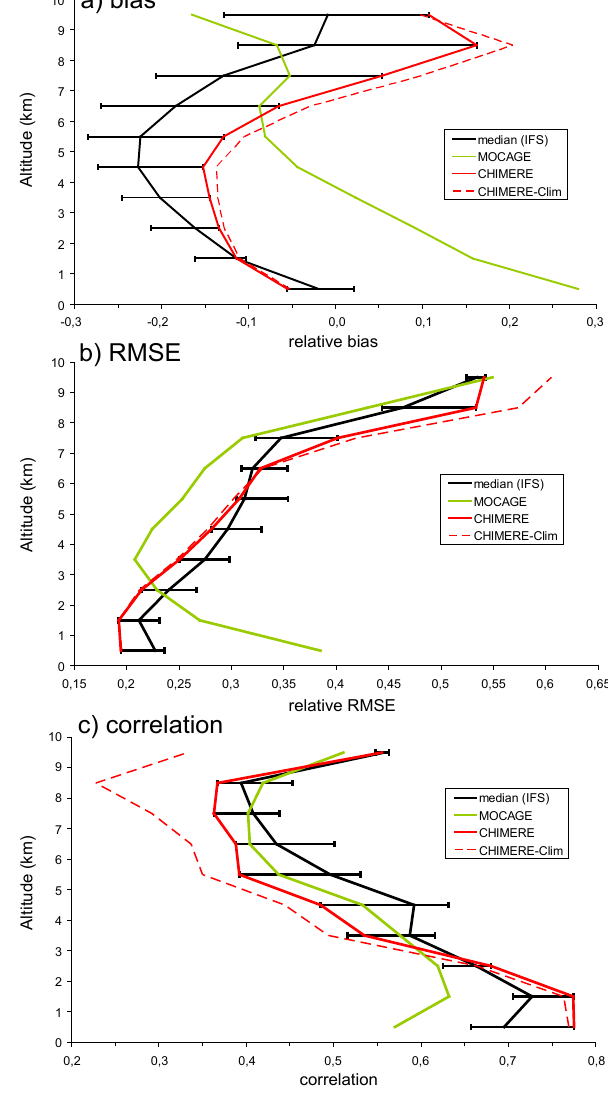
Fig. 3. Vertical profiles (y-axis inkm) of normalized (with respect to measurements) (a) relative bias (Model minus Observations), (b) relative RMSE and (c) Pearseon’s correlation coefficients. Values are averaged over 1km vertical layers using all 395 available pro- files of ozone. Black curves indicate the medians of the five models using IFS-MOZART at their boundaries (i.e. BOLCHEM, CAMX, CHIMERE, EURAD) and IFS-MOZART itself. Each value is also associated with the minimum and maximum value of the ensem- ble (bars). Results for MOCAGE (green), CHIMERE-IFS (full red) and CHIMERE Clim (dashed red) (i.e. CHIMERE using a monthly climatology derived from IFS-MOZART as BC) are also